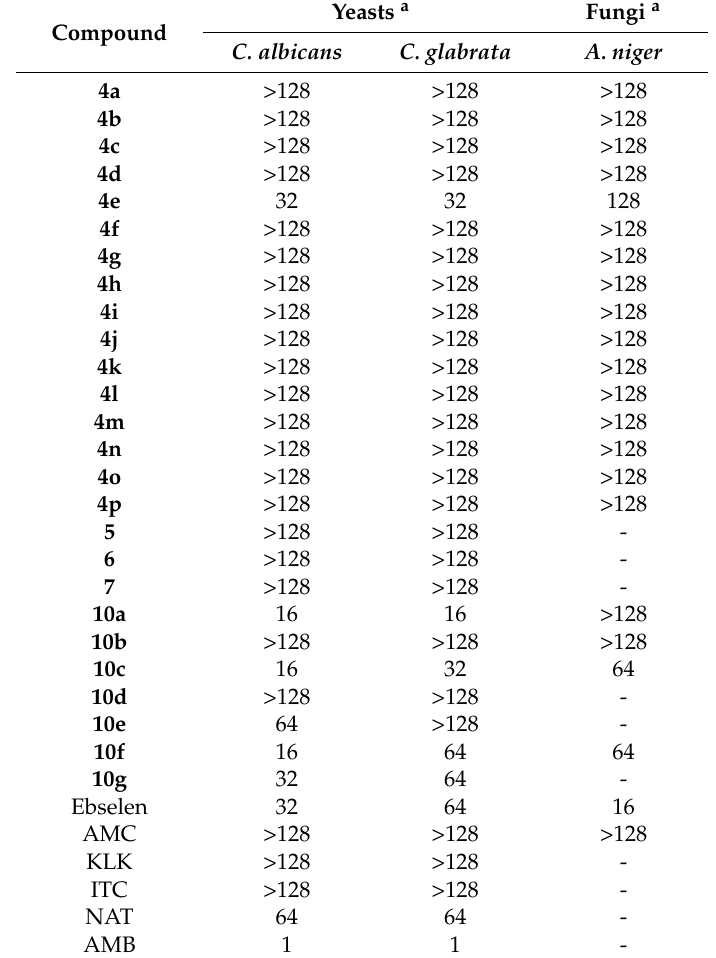
Table 3. Antifungal activity of compounds 4 – 7 , and 10